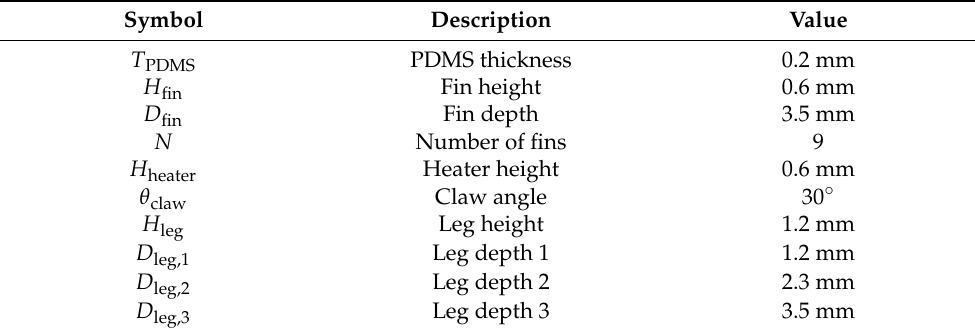
Figure 1. Overview of WIBot design. ( a ) Three-quarter section view of robot. Each leader line represents the robot’s components and materials. ( b ) Shape of robot’s legs for generating frictional force differences. ( c ) Description of relationship between legs and ground based on expansion and contraction of robot. Table 1. Key dimensions of WIBot design. (Symbols are illustrated in Figure 1).